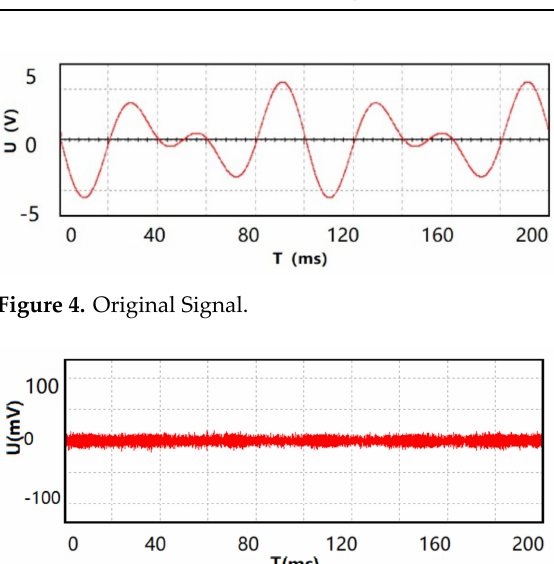
Figure 5. Noise Signal.